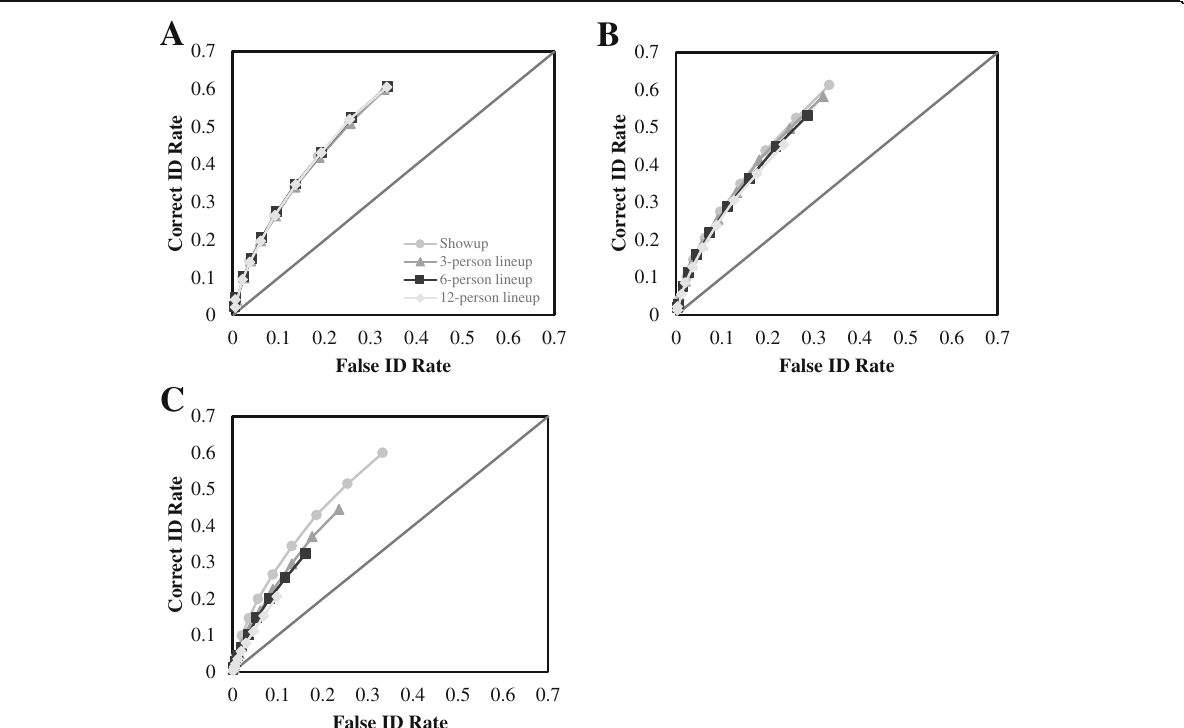
Fig. 4 Receiver operating characteristic (ROC) curves comparing showups, 3-, 6-, and 12-person biased sequential lineups. The value of SSP =.75, making the innocent suspect a better match to the PERP than the fillers. a SSF =0.0, b SSF =.3, c SSF =.6. Encoding constant at a =.3, and cseq = csu =.09. The solid diagonal line indicates chance performance. SSP Similarity of the innocent Suspect to the PERP, SSF Similarity of the Suspect to the Fillers, PERP